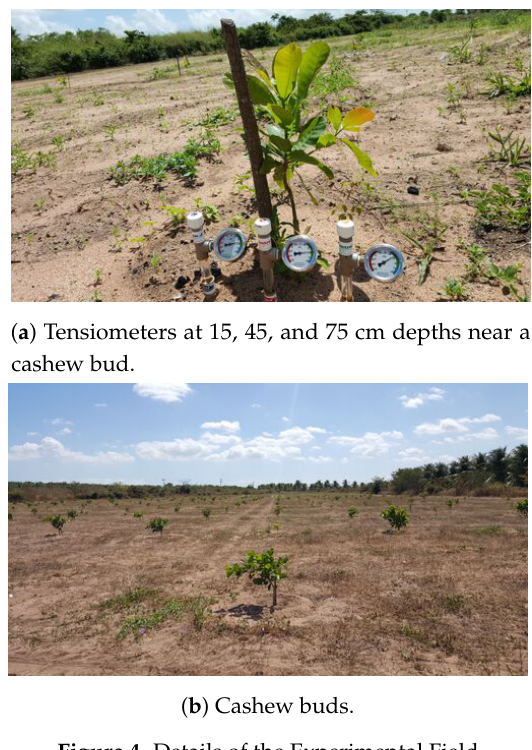
Figure 4. Details of the Experimental Field.